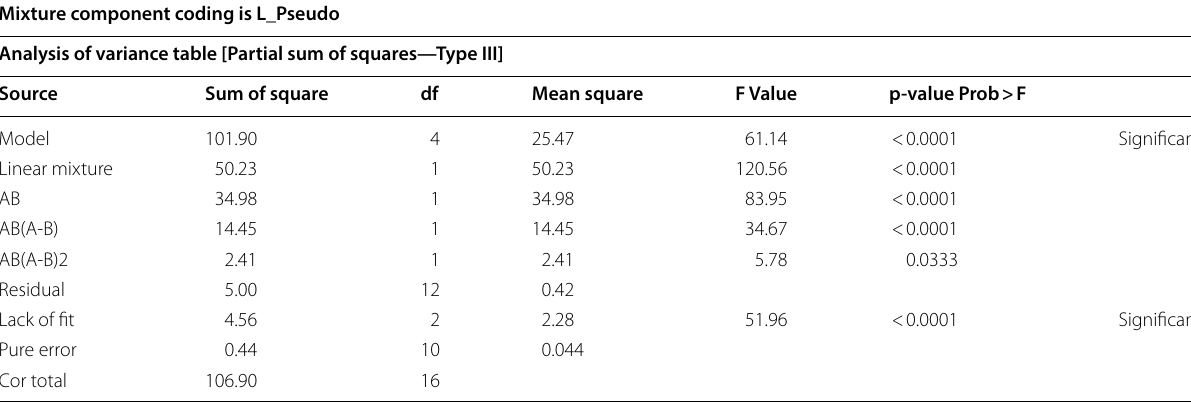
Table 3 ANOVA for quartic mixture model for the response 1: Xmax Mixture component coding is L_Pseudo Analysis of variance table [Partial sum of squares—Type III]